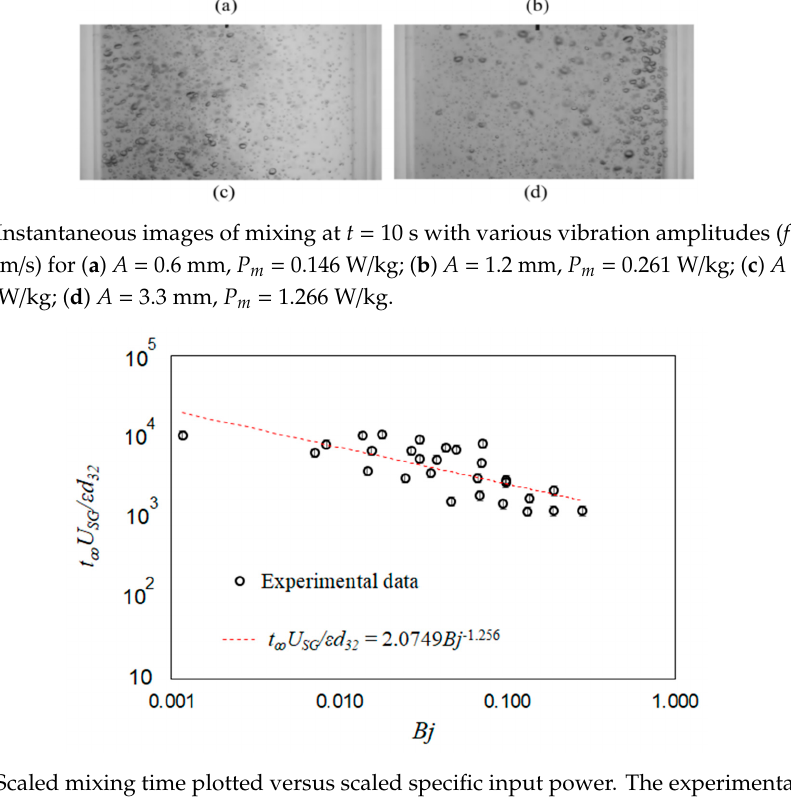
Figure 16. Scaled mixing time plotted versus scaled specific input power. The experimental data are compared against a dimensionally reasoned correlation.